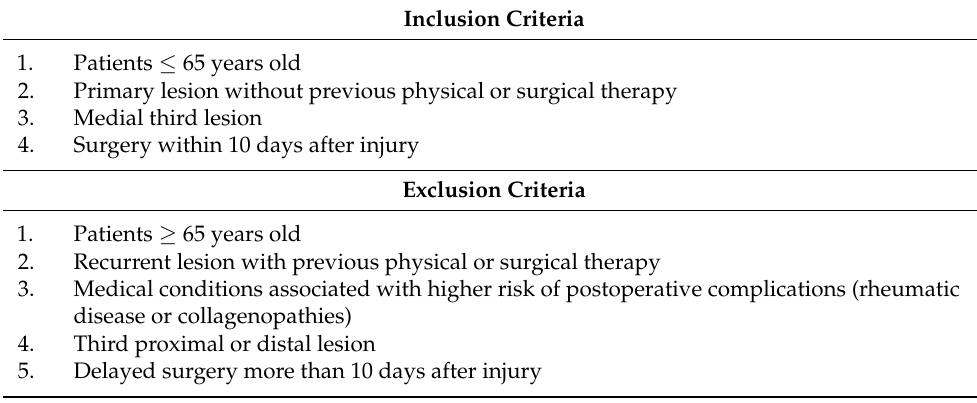
Table 1. Inclusion and exclusion criteria.